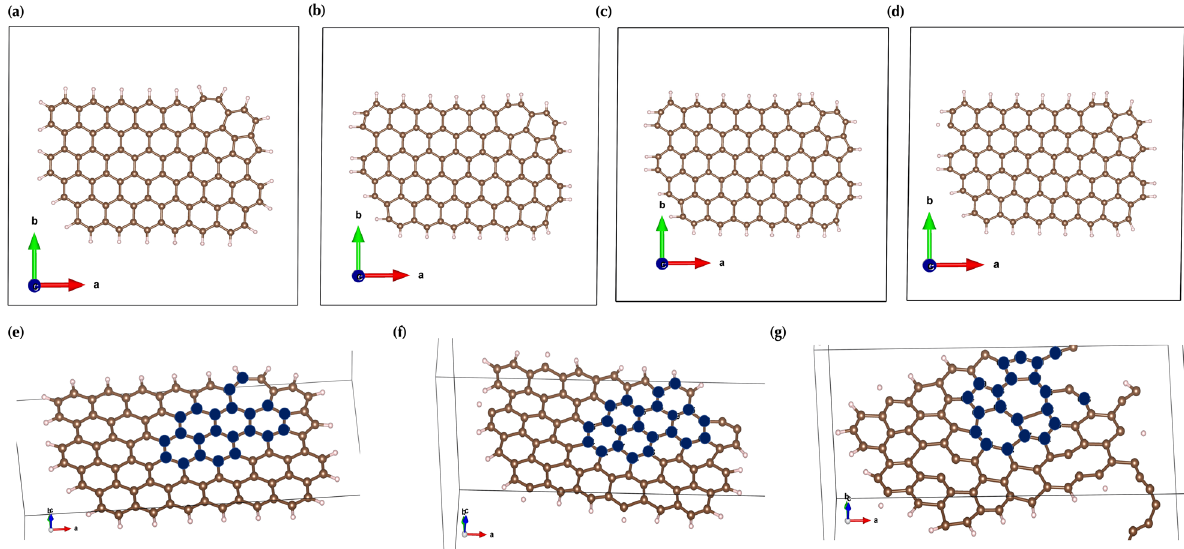
Fig. 4 Optimized geometries obtained using DFT within GGA computations and AIMD simulations. Figure a shows the fully relaxed structure while b – d are the resulting optimized geometries using three different selective dynamics con fi gurations. Figure e – g represents the resulting structures of graphene after 2 ps at 300, 2000, and 4000 K,